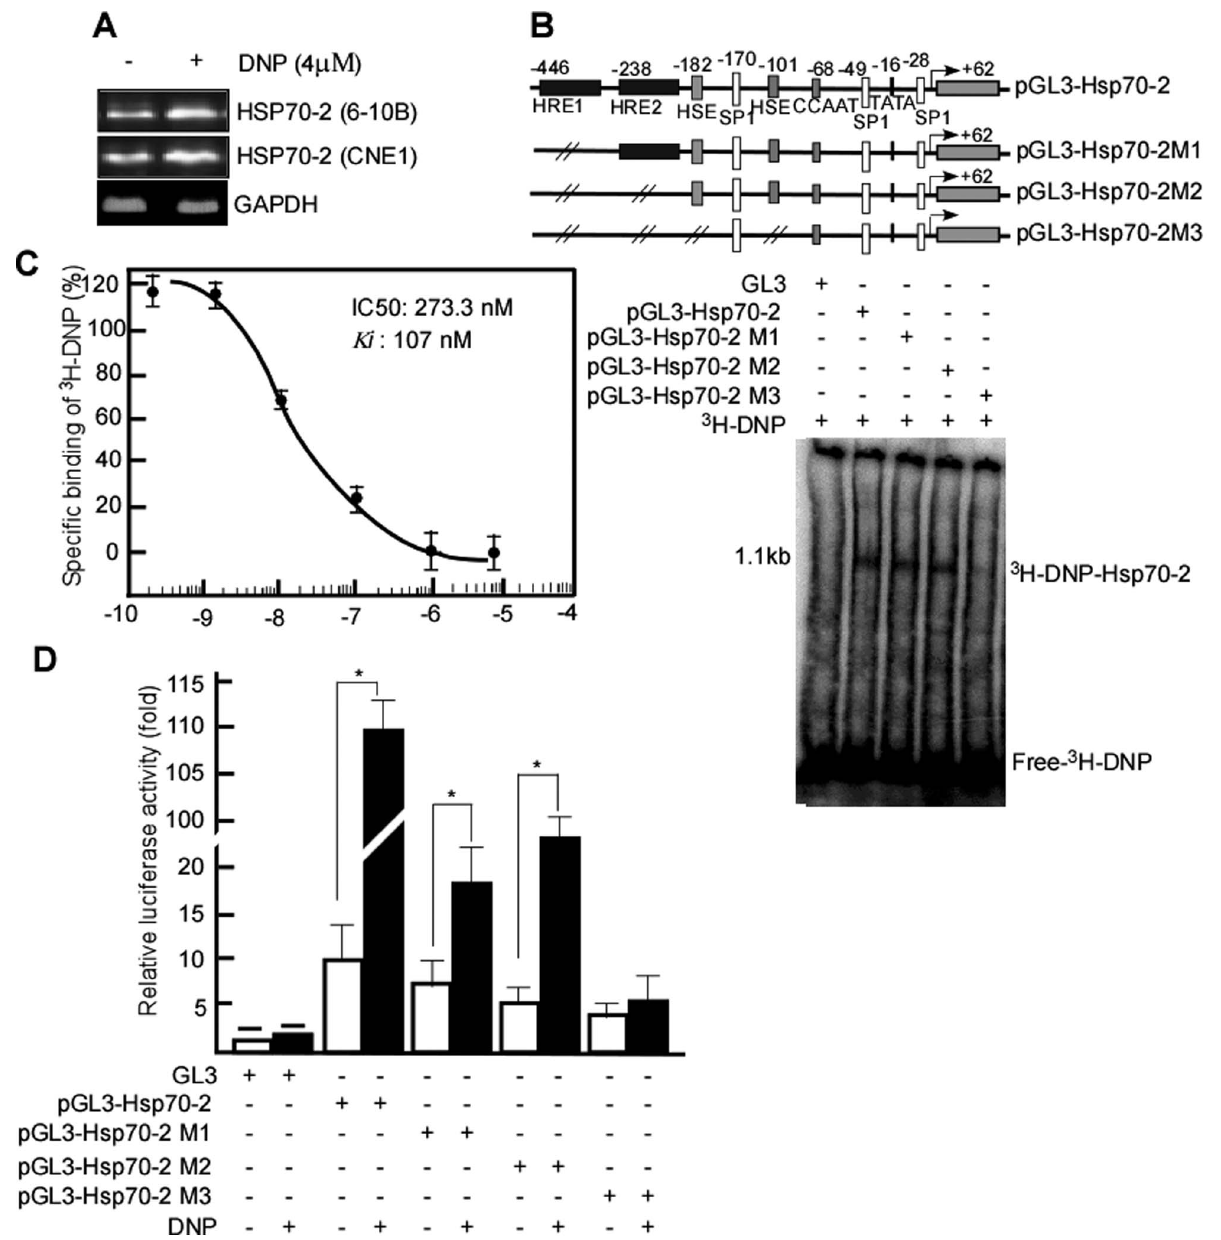
Figure 3. DNP-mediated HSP70 RNA transcription through HSP70-2 promoter interaction. A, DNP-mediated Hsp70 transcription was detected in 6-10B and CNE1 cells by RT-PCR. B, Schematic of the HSP70-2 promoter and its mutations. HSP70-2 promoter, the full length of promoter; HSP70-2M1, HER1 promoter mutation; HSP70-2M2, HER1, and HER2 mutation; HSP70-2M3, HER1, 2 and HSE mutation. HSP70-2 promoter and its mutations were respectively incubated with 3 H-DNP, and the reactive complexes were separated by SDS-PAGE for autoradiography. C, The affinity was determined by displacement of 3 H-DNP from the HSP70-2 promoter. IC50 of DNP interaction with HSP70-2 promoter was 273.3 nM, and Ki was 107 nM. D, Relative firefly luciferase activities were normalized by the Renilla luciferase activity (mean 6 SD). The relative luciferase activity indicates the transcriptional activity of the HSP70-2 promoter and its mutation with or without DNP treatment.